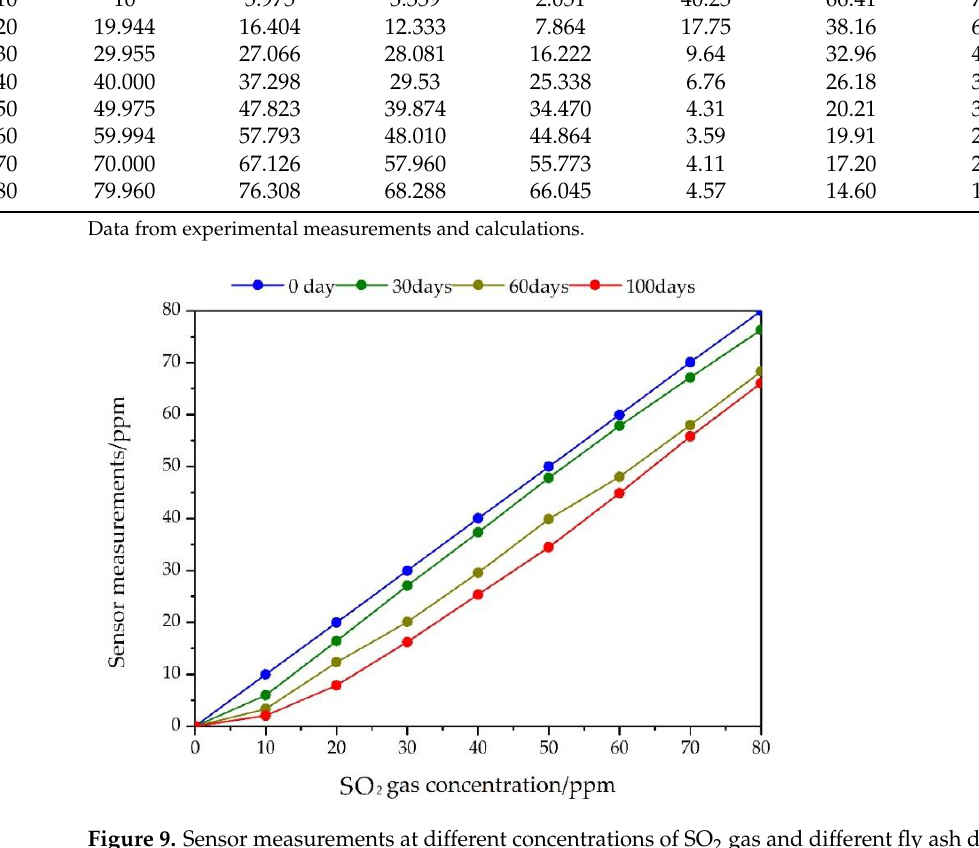
Figure 9. Sensor measurements at different concentrations of SO 2 gas and different fly ash deposition times.